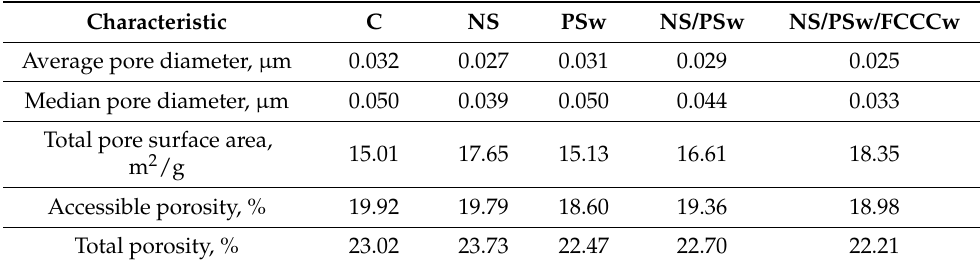
Table 3. Mercury intrusion porosimetry (MIP) results in terms of pore diameters (average, median), total surface, accessible and total